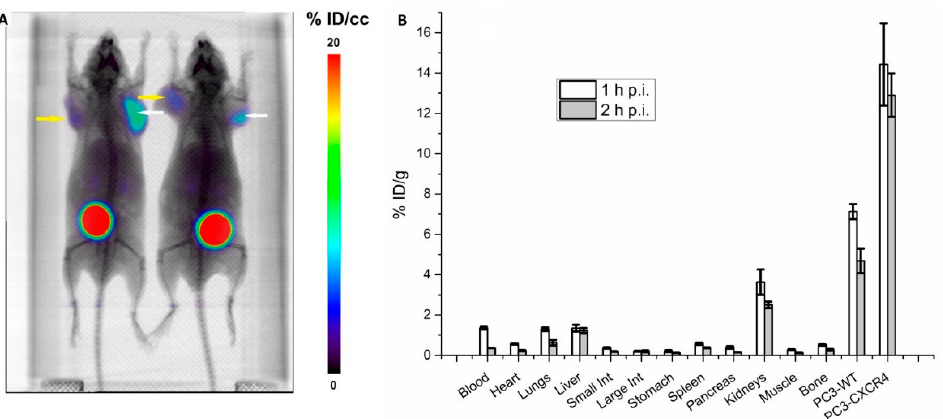
Figure 2. Tissue distribution of [ 68 Ga]Pentixafor in male BALB / C nu / nu mice bearing subcutaneous bilateral PC3-WT (yellow arrow) and PC3-CXCR4 (white arrow) tumors. ( A ) Imaging of CXCR4 expression by microPET / CT. Mice were injected intravenously with 5.5 MBq [ 68 Ga]Pentixafor and imaged at 1 h p.i. ( B ) Biodistribution of [ 68 Ga]Pentixafor. Mice were injected with 1.85 MBq and sacrificed at 1 h ( n = 5) and 2 h ( n = 5) p.i.